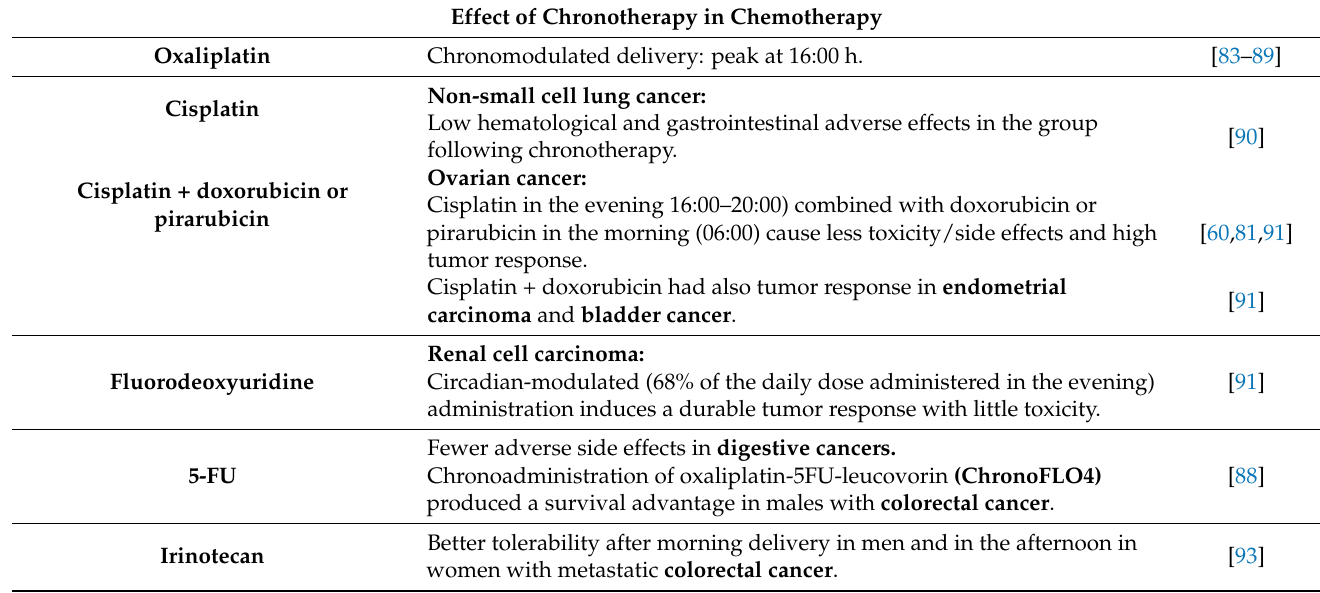
Table 2. Summary of some chronotherapeutic approaches applied in cancer therapy. Effect of Chronotherapy in